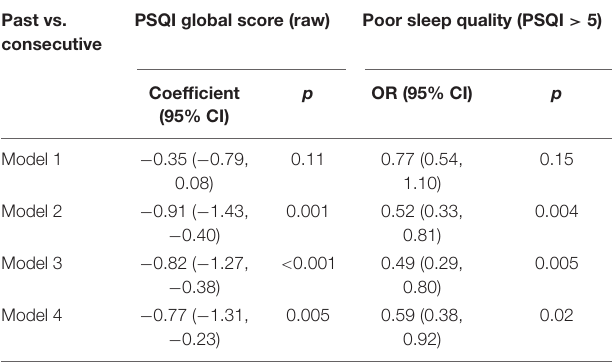
TABLE 2 | Linear and logistic regressions to explore the difference in sleep quality between nurses working consecutive night shifts and nurses having worked past night